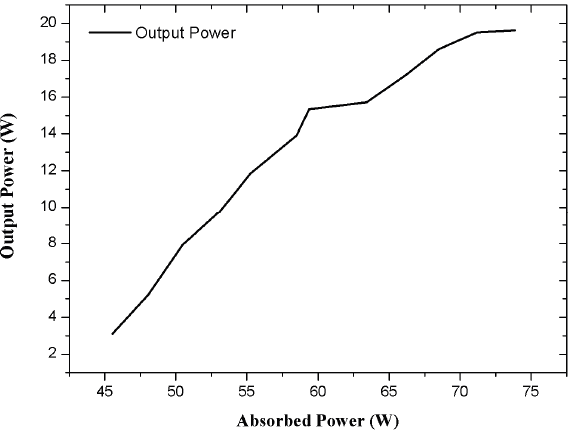
Figure 2. The spectral intensity distribution as a function of absorbed pump power.